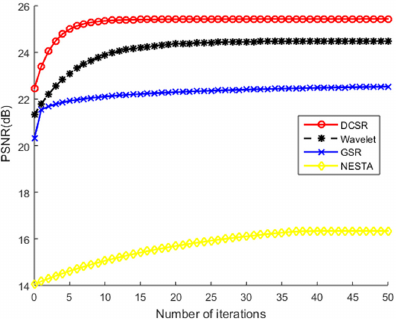
Figure 11. PSNR values of Barbara’s grayscale image recovered by four competing methods as a function of the number of iterations. The test image is corrupted by AWGN.